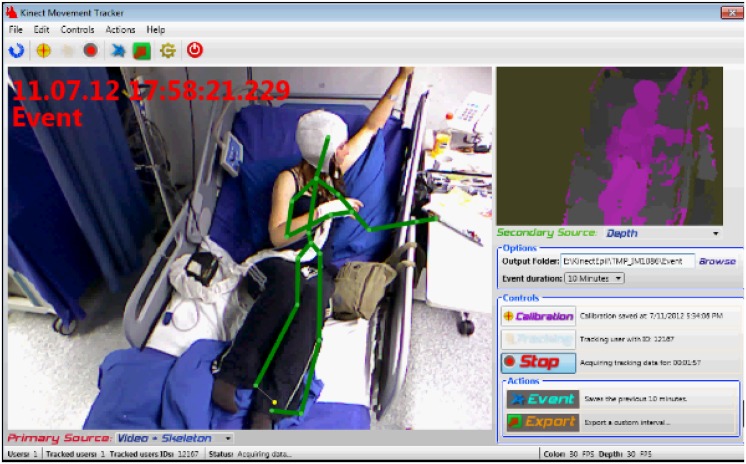
KiT first integration in the routine of University of Munich EMU (circa 2012).